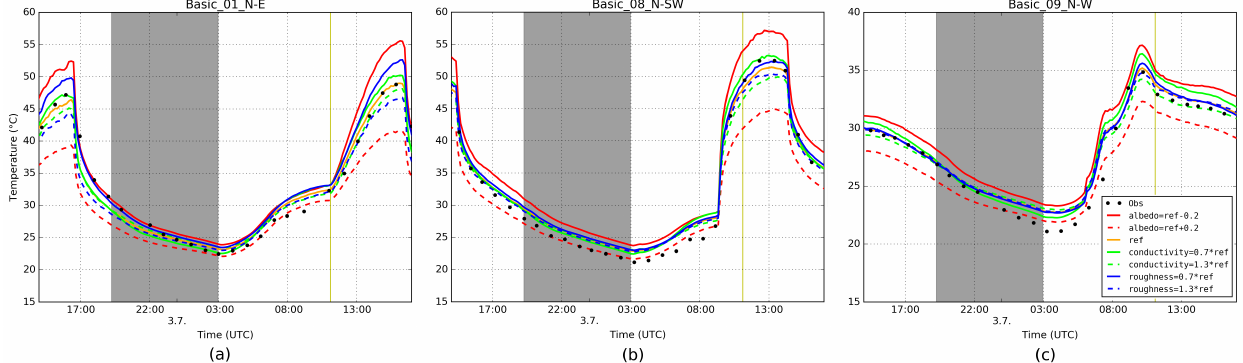
Figure 18. The sensitivity of PALM-USM to changes in surface and material parameters: (a) for the west-facing wall measured from location 1 for evaluation point 1, (b) for the ground measured from location 8 for evaluation point 3, and (c) for the east-facing wall measured from location 9 for evaluation point 5. ref is the reference run; other lines correspond to the increase (dashed line) and decrease (solid line) in the respective parameters with respect to the reference run: albedo was increased/decreased by 0.2, thermal conductivity of materials and skin surface layer (conductivity) was increased/decreased by 30%, and so was the roughness length (roughness). Obs is the measurement in the evaluation